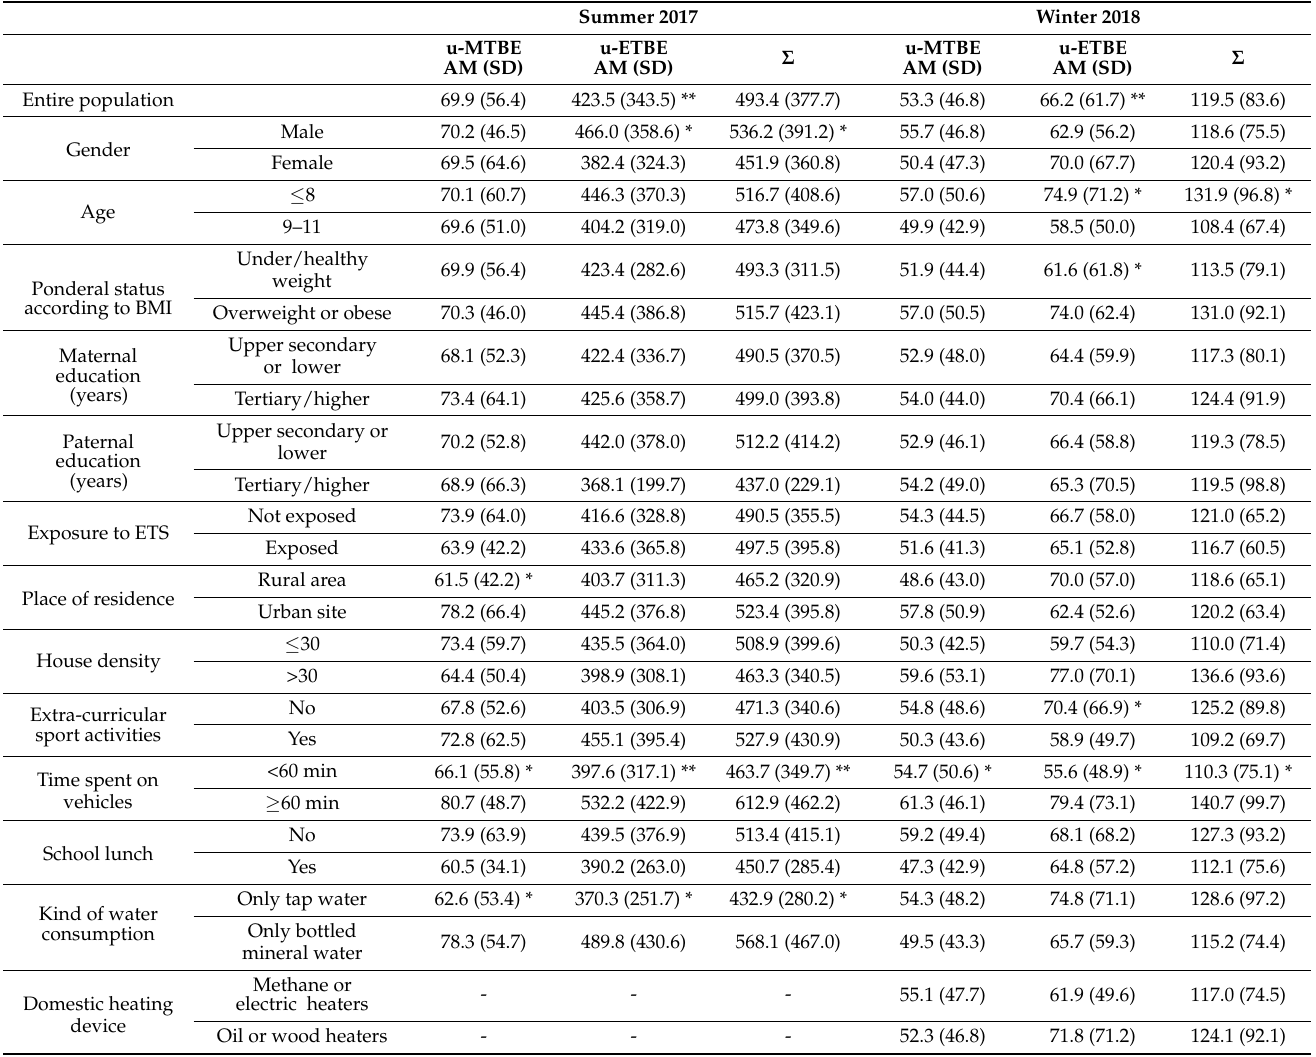
Table 2. Urinary concentrations (ng L − 1 ) of methyl tert-butyl ether (MTBE), ethyl tert-butyl ether (ETBE), and their sum ( Σ ), in children grouped according to some personal characteristics, their living environments and activity carried out in the sampling day. Values are expressed as arithmetic mean (AM) and standard deviation